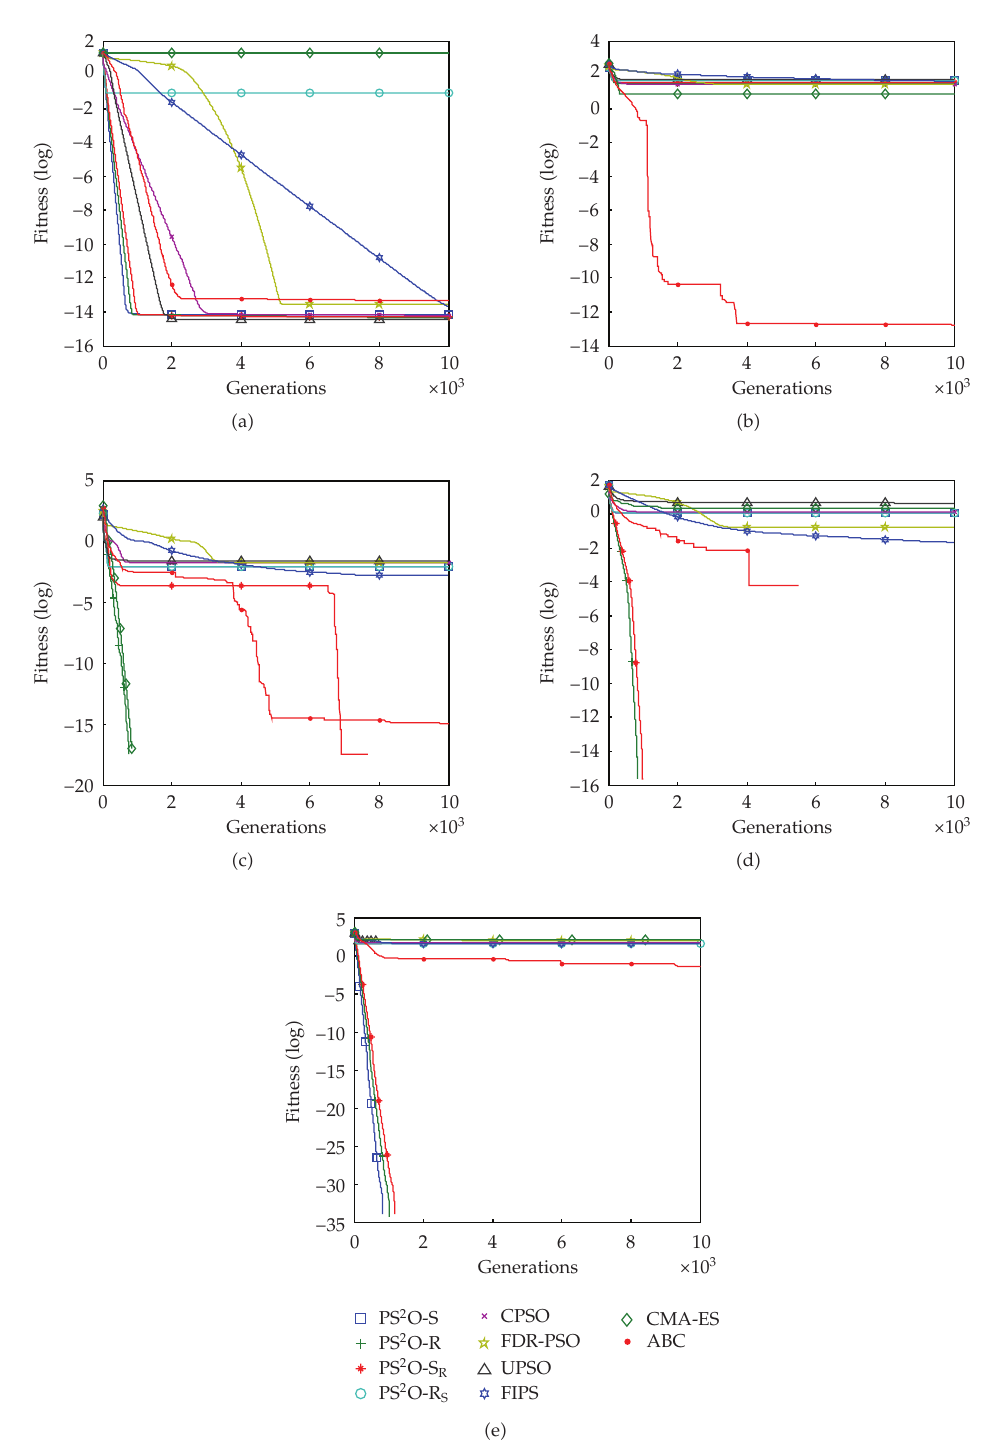
Figure 10: The median convergence results of 30D multimodal continuous functions. (cid:2) a (cid:3) Ackley’s function. (cid:2) b (cid:3) Rastrigin’s function. (cid:2) c (cid:3) Griewank’s function. (cid:2) d (cid:3) Weierstrass function. (cid:2) e (cid:3) Composition function